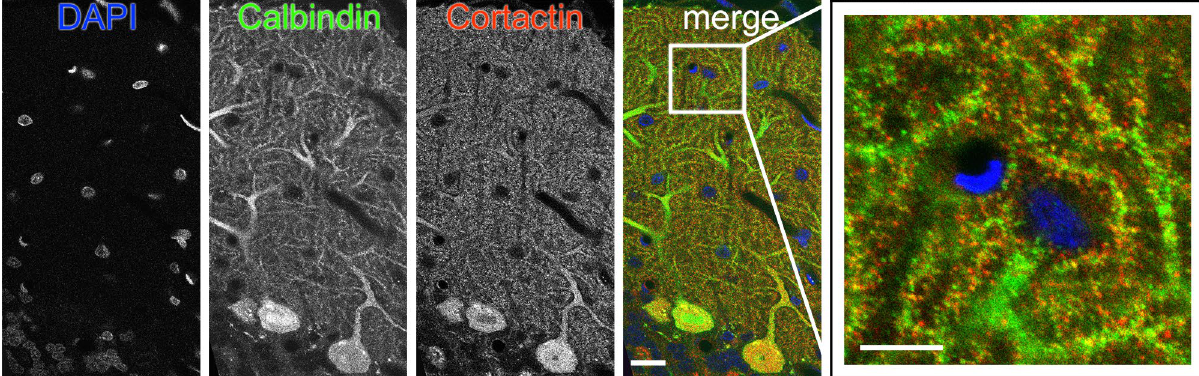
Figure 2. Cortactin colocalizes with calbindin in PCs. Confocal microscopy shows cell nuclei (DAPI, blue), the PC-specific calcium-binding protein Calbindin (Alexa-488, green), and cortactin (Cy3, red). The two markers almost completely colocalize in the molecular layer of the cerebellum. The inset is the expanded image of the region surrounded by a white rectangle. Scale bar: 20 µm, 10 µm for the inset.